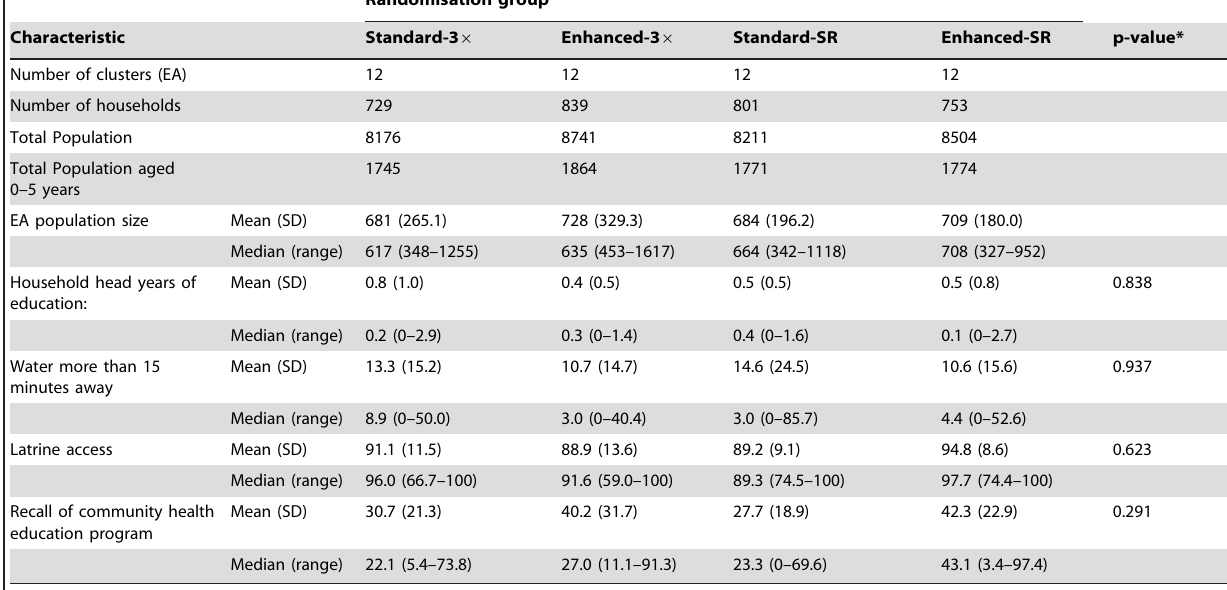
Table 1. Baseline characteristics.